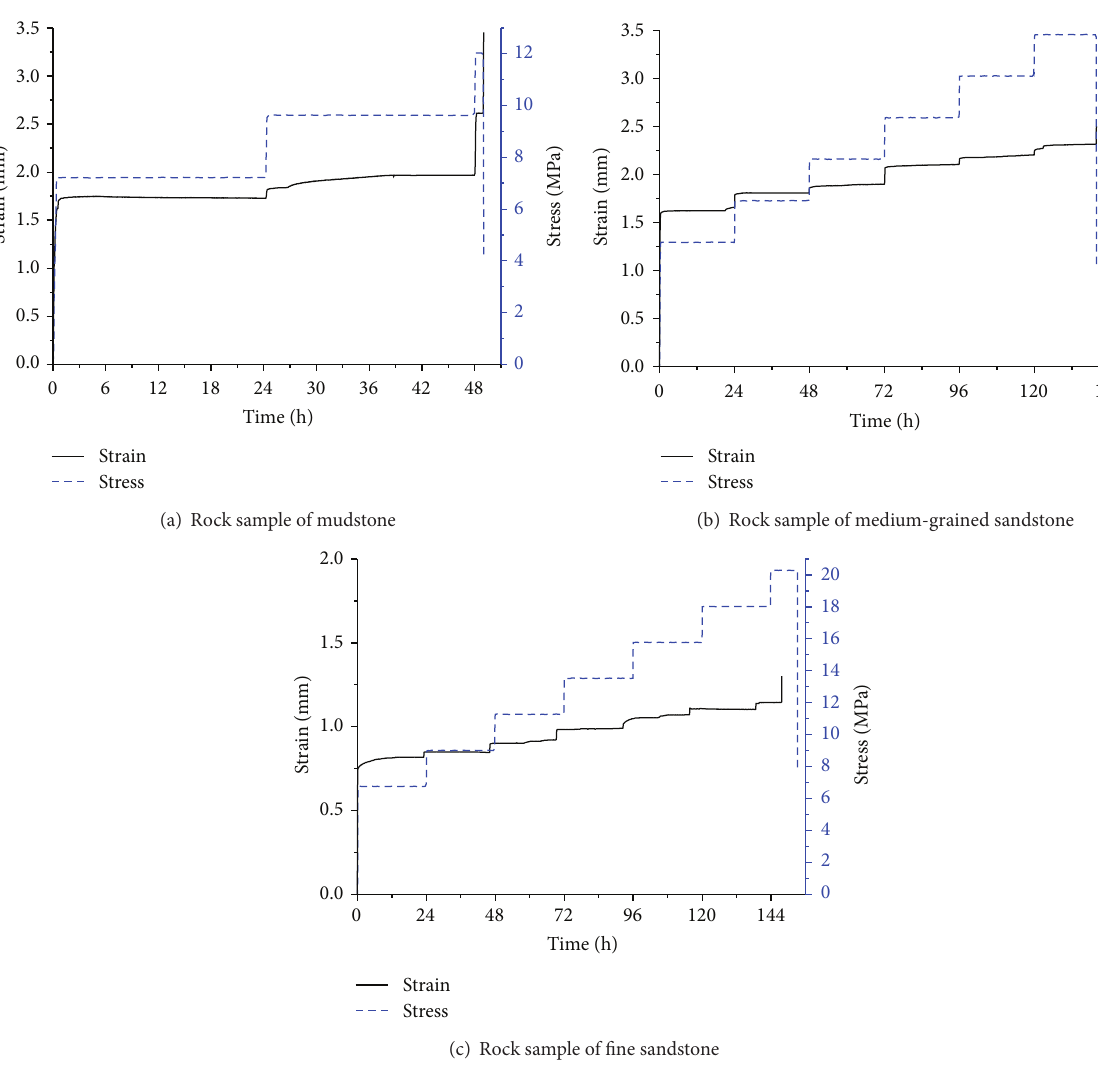
Figure 7: Uniaxial creep strain and creep stress